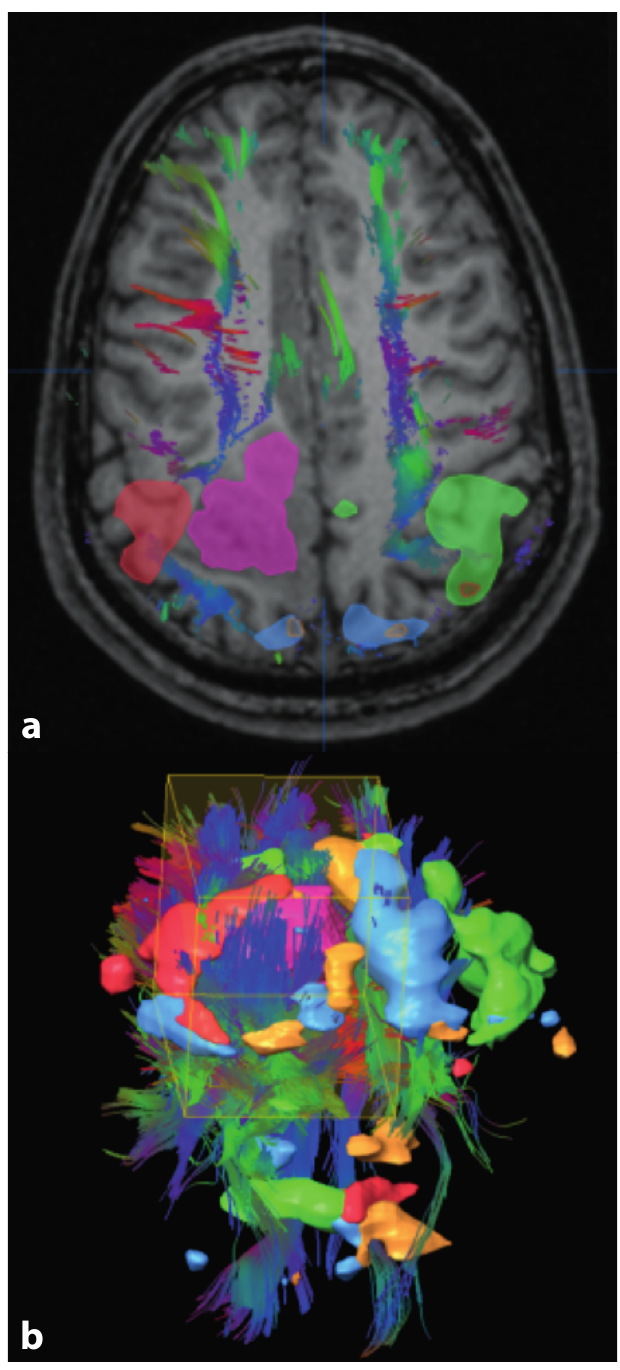
Fig. 2. DTI fibre tractography and fMRI activation (a) overlaid onto an axial slice of the MPRAGE image at the level of the tumour, and (b) rendered in 3 dimensions. The corona radiata fibres in the left hemisphere in (a) are pushed laterally by the tumour. Some of the fibres deviated by the tumour can be seen in (b) to pass posteriorly and even superiorly to the tumour. The yellow box in (b) shows the manually-defined region used to seed the fibre tracking. The fibre colours correspond to the predominant fibre direction (green is antero- posterior; blue is crano-caudal; red is